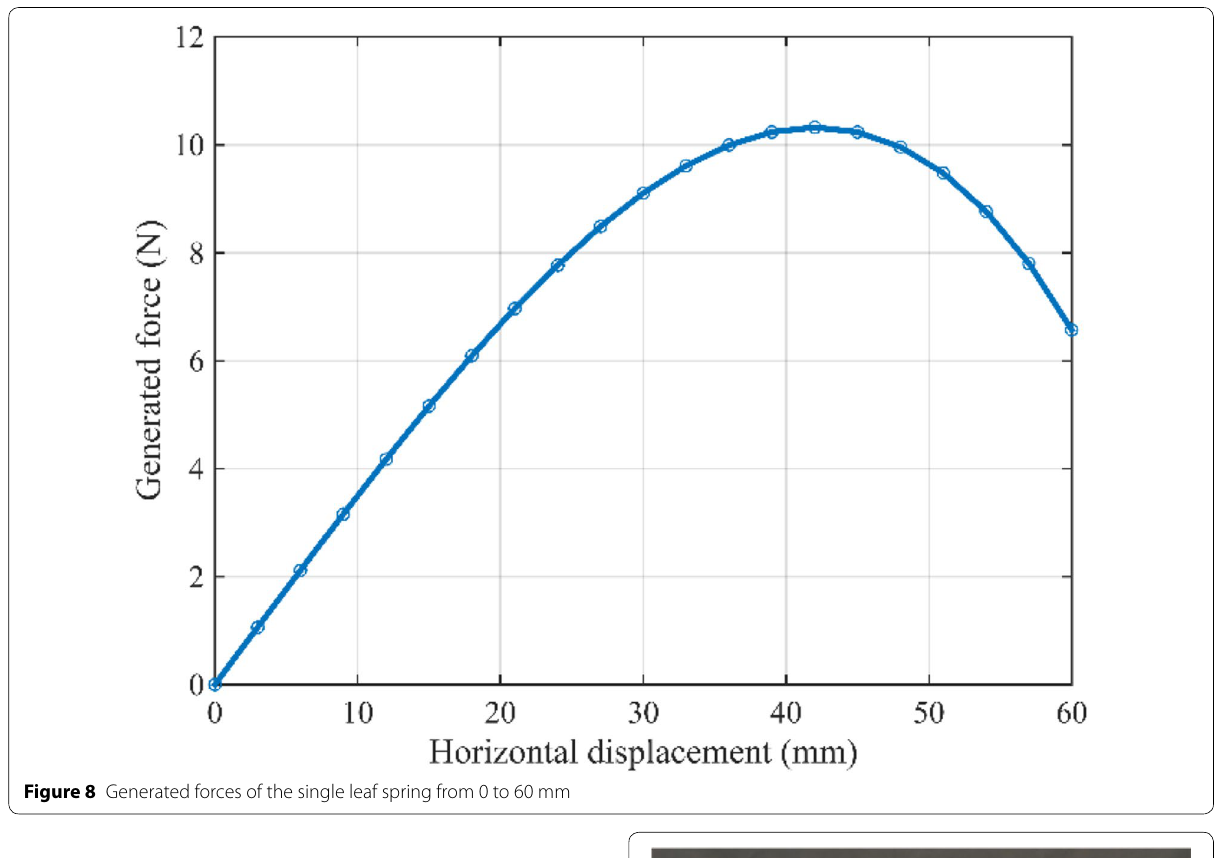
Figure 8 Generated forces of the single leaf spring from 0 to 60 mm